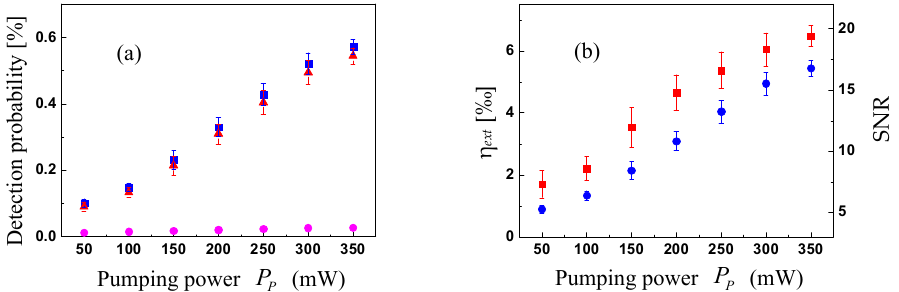
Figure 5. ( a ) Detection probability with ( D s , blue squares) and without ( D n , pink circles) input signal ( µ in = 5 ) as a function of the pumping power P P . The red triangles are the net signal ( D s − D n ). ( b ) The SNR of the converted field after the filtering system as a function of the pumping power P P (red squares, right axis). The external device conversion efficiency η ext is shown by the blue circles on the left axis.